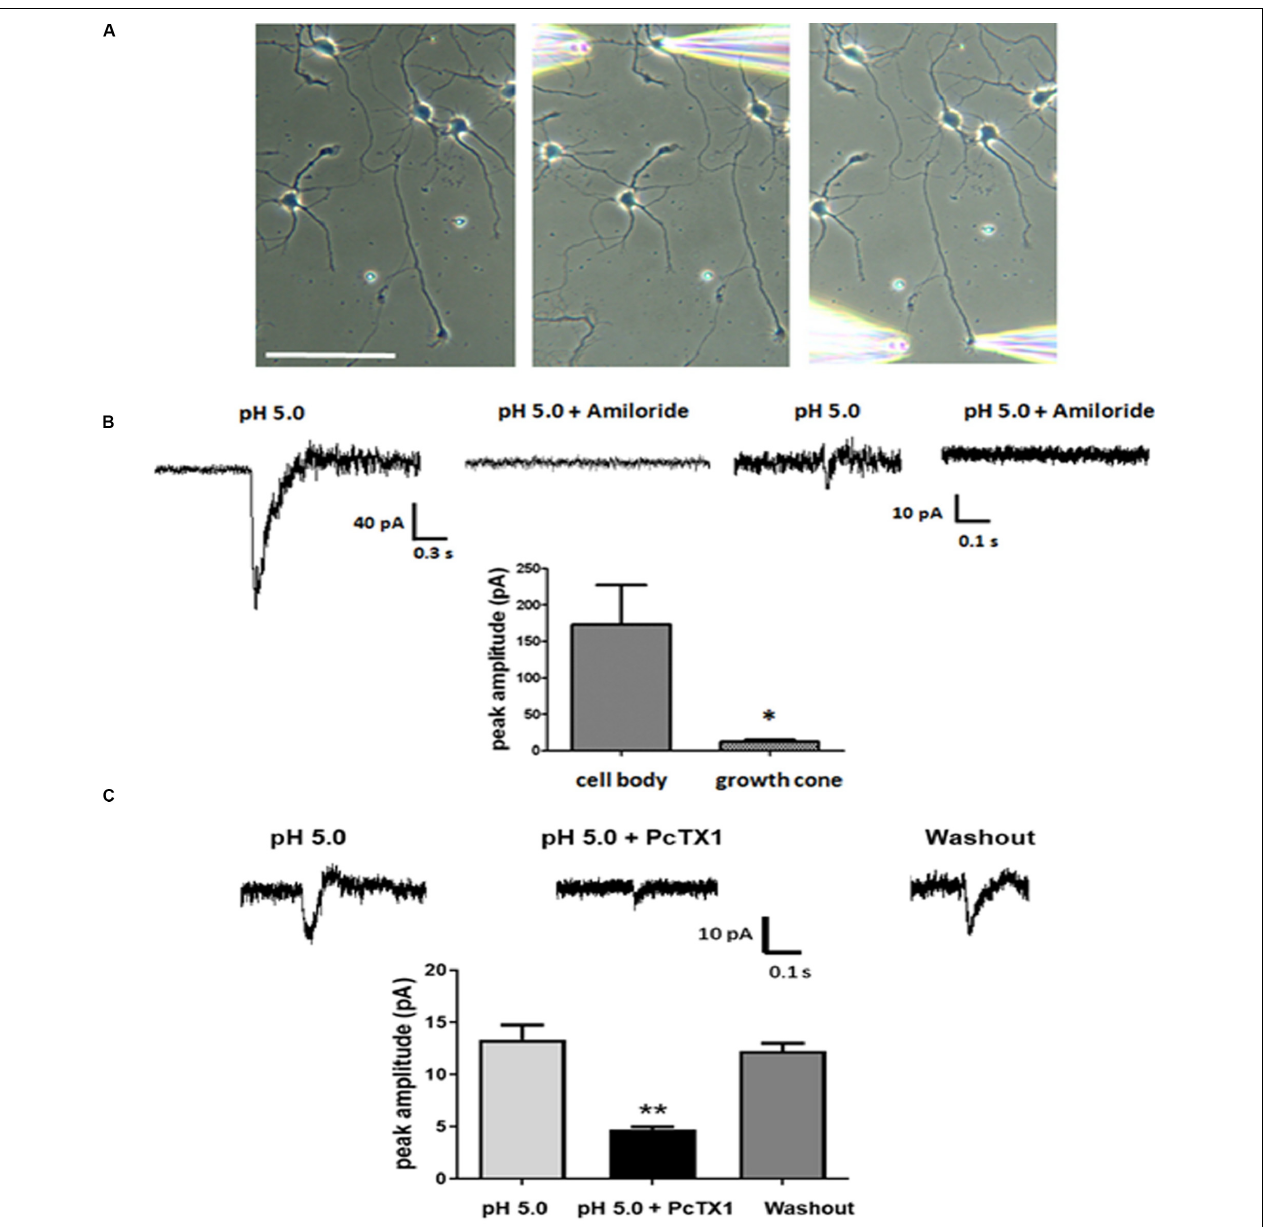
FIGURE 3 | Functional ASICs are present at axonal growth cones. DIV5 and DIV6 primary hippocampal neurons were voltage-clamp at –70 mV. pH 5.0 acid extracellular solution was applied to the cell body and the growth cone by pressure application (4–6 psi, 1 s). (A) The image of a representative neuron from which the currents were recorded in response to acid extracellular solution administration. The positions of the application pipette and recording pipette are shown. Scale bar, 100 µ m. (B) Electrophysiological recordings were performed in the presence of TTX (1 µ mol/L). To test the specificity of the ASIC-mediated response at cell body and growth cones, 200 µ mol/L Amiloride was added to the acid extracellular solution. Average peak amplitudes for ASICs currents at the cell body and growth cones were 132 ± 40.8 pA ( n = 7) and 14.1 ± 1.6 pA ( n = 11), respectively. Data are means ± SEM and analyzed by unpaired Student’s t -test, *p <